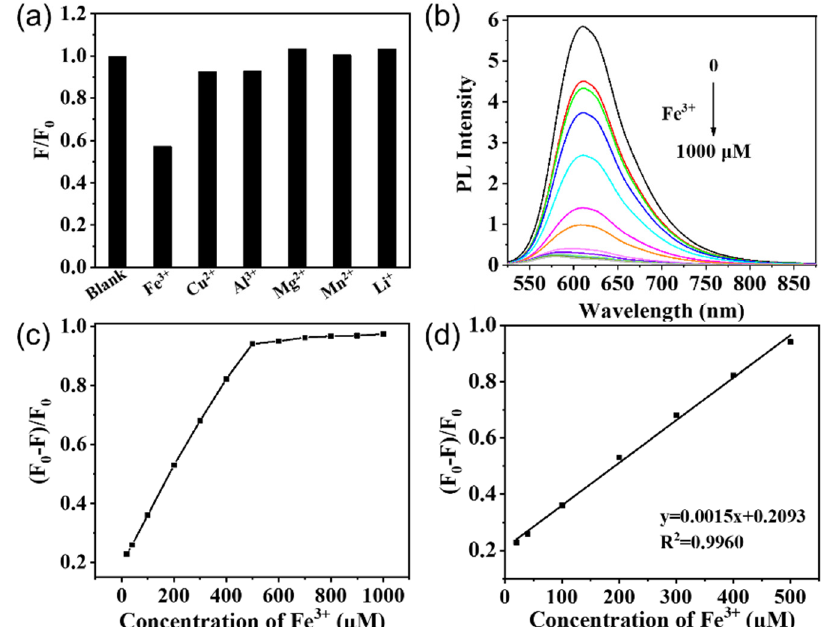
Figure 7. ( a ) Fluorescent responses of 100 µM CDs-1 to different metal ions. ( b ) The fluorescent response of CDs-1 to the addition of different concentrations of Fe 3+ . ( c ) Plots of the (F 0 − F)/F 0 with different concentrations of Fe 3+ . ( d ) The PL intensity F is linearly related to the concentration of Fe 3+ over the ranges from 20–500 µM.